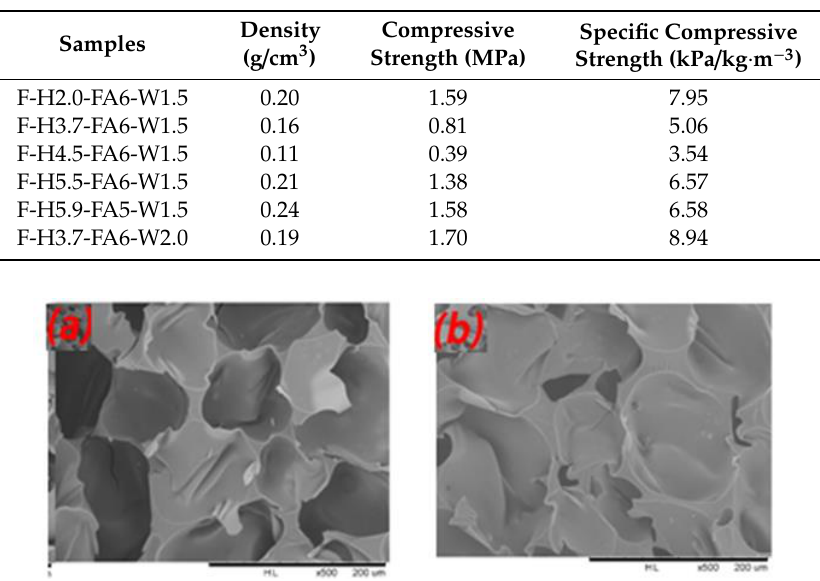
Table 3. Apparent density, compressive strength and specific compressive strength of tannin – humins foams.